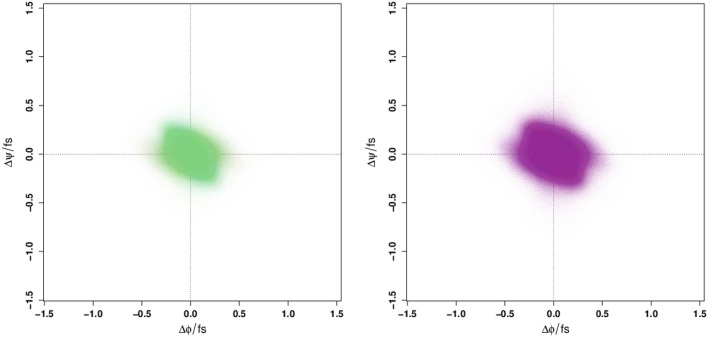
Angular velocity distributions by dihedral angle colored by residue index (Left panel) and by protein (Right panel). No systematic variation is visible in either case.